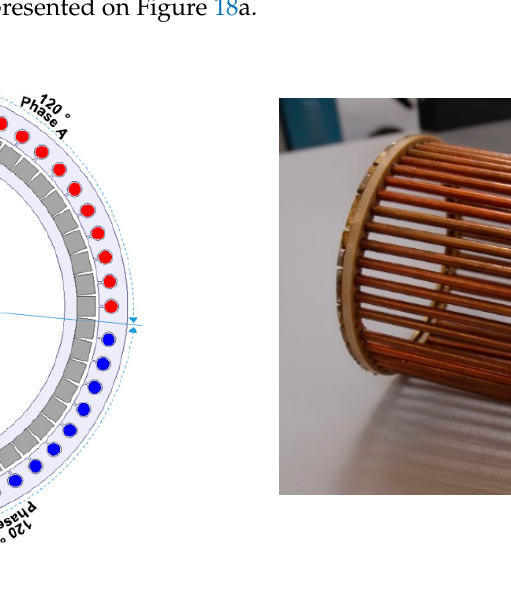
Figure 18. Description of motor: ( a ) Dental winding by group, ( b ) Winding view. To reduce the mass of the motor, we increased the operating frequency so the number of poles of the motor would increase. The increase in frequency imposes a constraint on the mechanical feasibility of tooth size. For this type of winding, we have two relationships, namely a relation between the number of slot N S and the number of magnet N R = 2.p and a relation for the dimension of the dephasing tooth δ ph and the number of slot N S . This system of this equation is given by the system of Equation (28). In this configuration of winding N S must be a multiple of 3 [17].